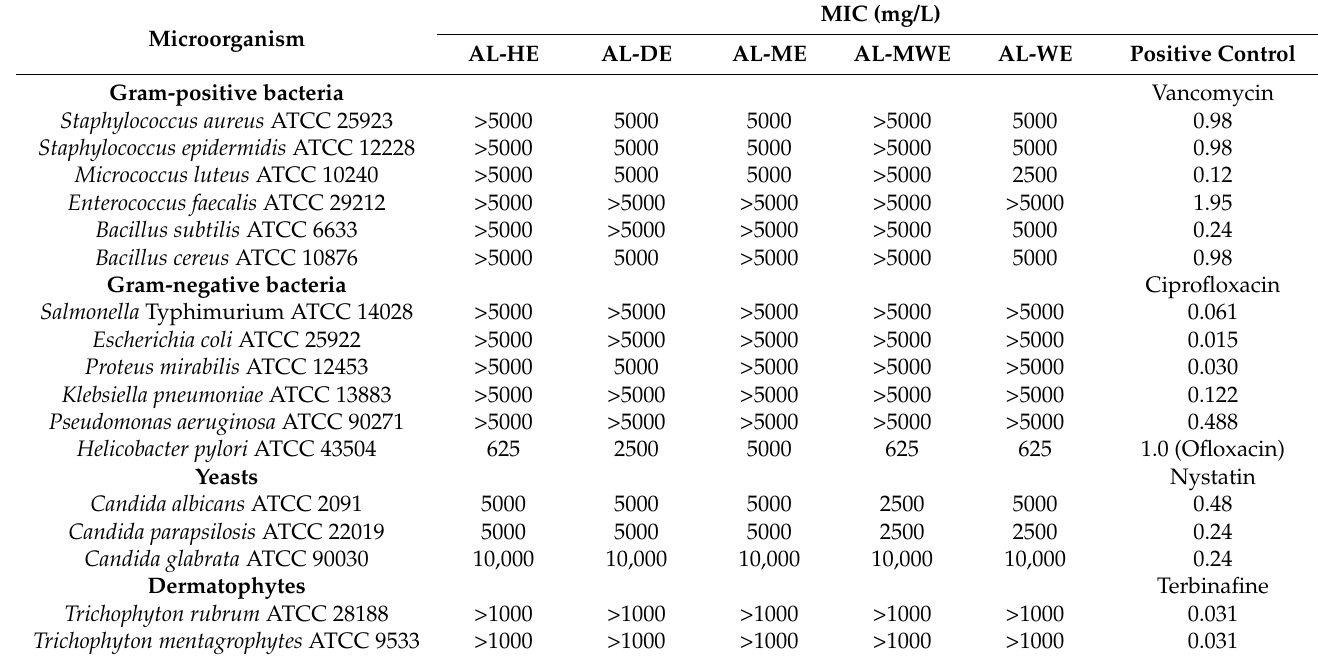
Table 5. Antimicrobial properties of the Artemisia campestris subsp. lednicensis